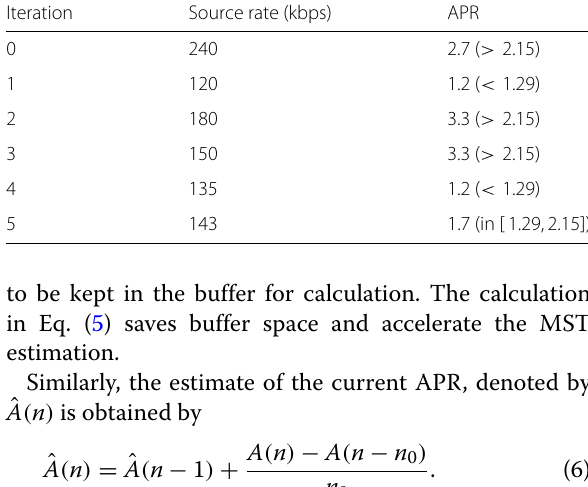
Table 1 Iterations of Algorithm 1: an example Iteration